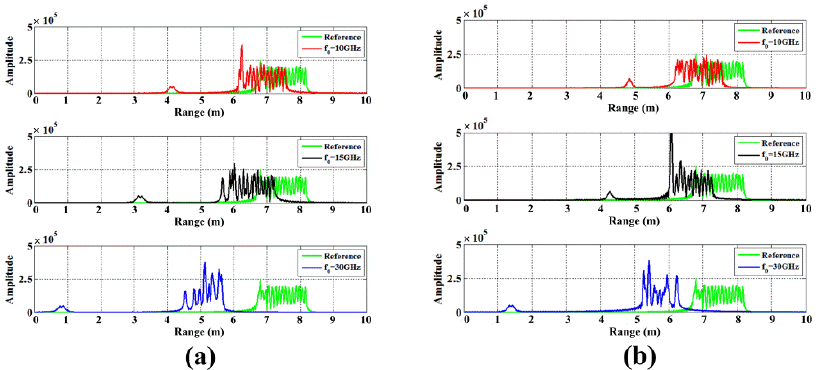
Figure 18. One-dimensional range profiles of the hypersonic target in scenes 4 and 5. ( a ) Velocity is Mach 20. ( b ) Velocity is Mach 25.